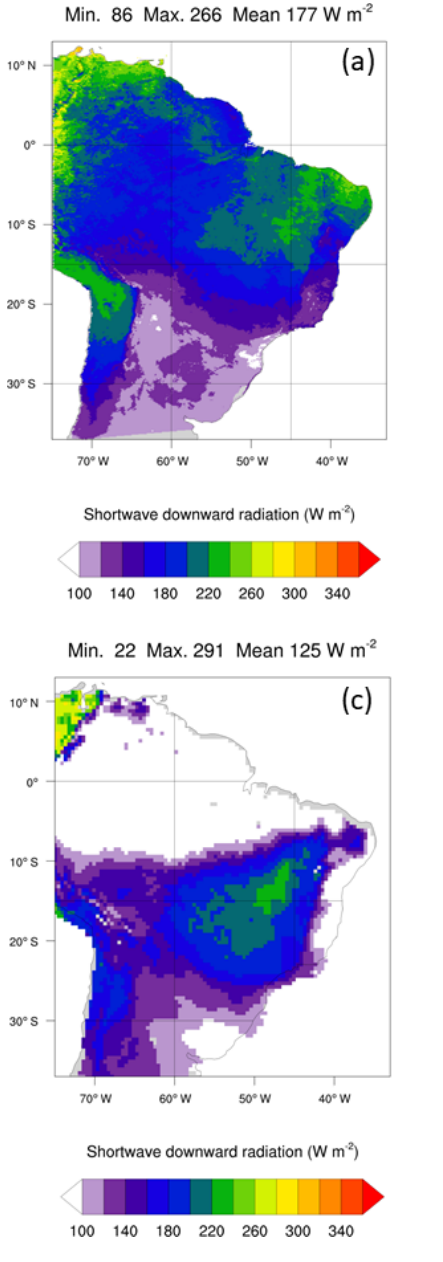
Figure 5. Monthly averaged surface short-wave downward radiation (Wm − 2 ) over South America during May 2015. (a) denotes the LSA SAF satellite observation, (b) denotes the CP simulation, and (c) denotes the NCP simulation. No data are available over the ocean, and water areas are masked in the CP and NCP